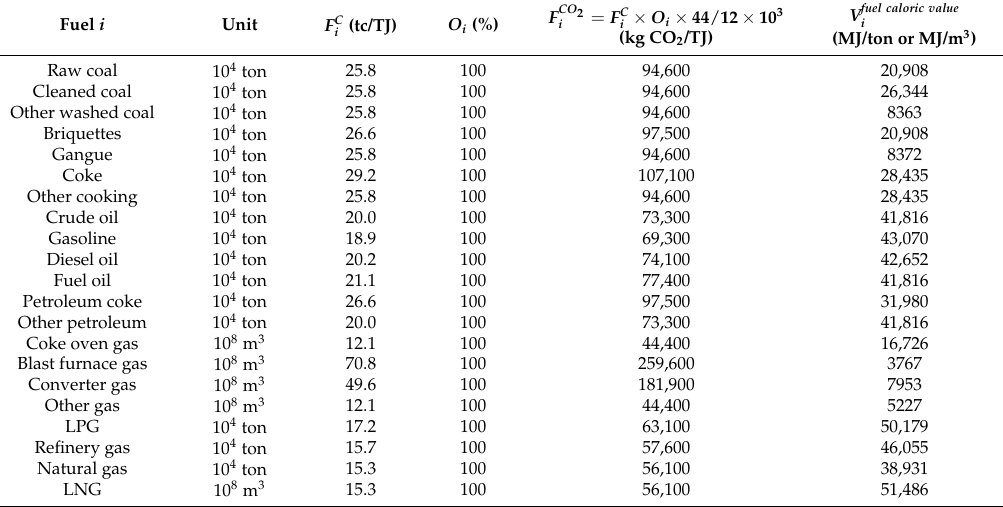
Table 2. The carbon emission factor F C , carbon oxidation factor O i , CO 2 emission factor F CO 2 i caloric value V fuel caloric value of fuel i i